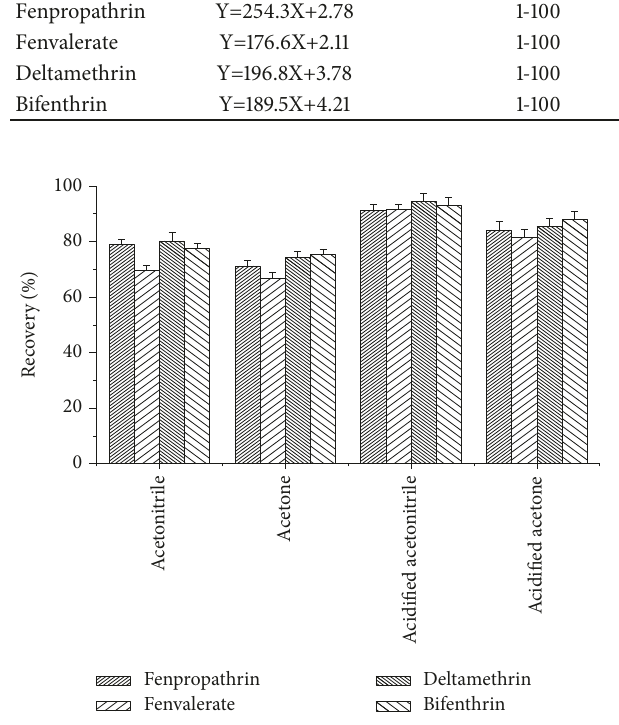
Figure 7: Effect of desorption solution. Extraction conditions: sam- ple volume, 50.0 mL spiked with 100 ng mL −1 of four pyrethroids; pH, 7.0; ultrasonication time, 2 min; magnetic nanoparticles (MNPs), 60